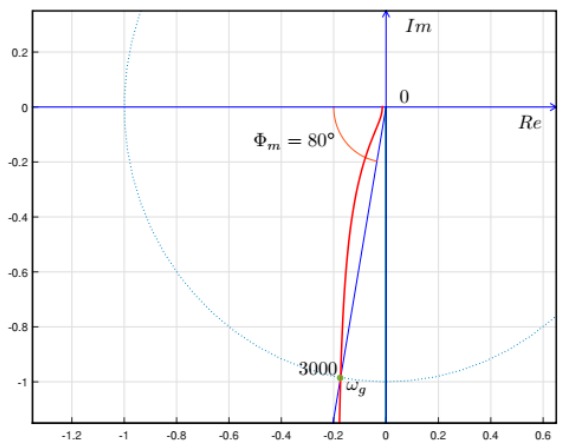
Figure 7. ( a ) Open-loop step response (green), closed-loop step response (red) and ( b ) the corresponding average duty cycle d t ( t ) (blue).